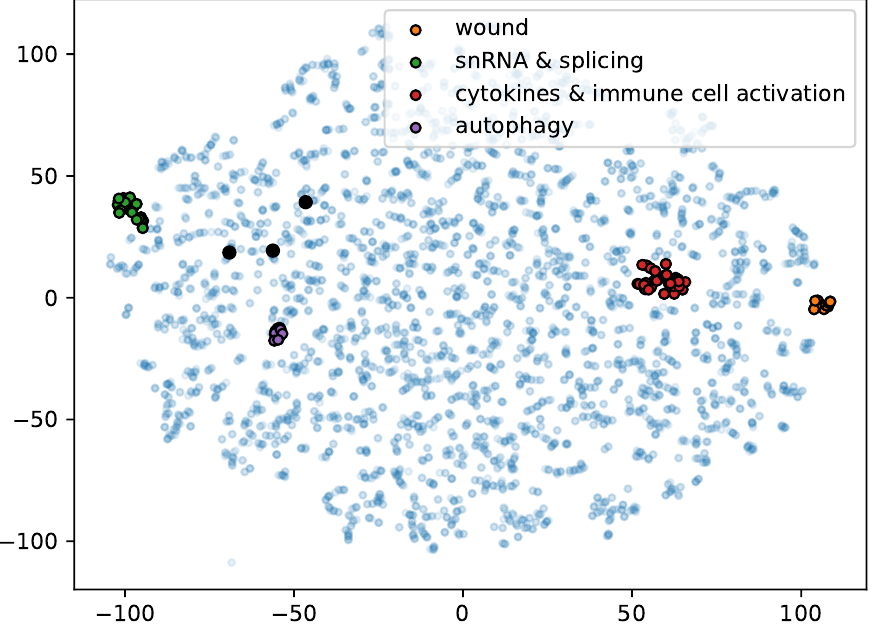
Figure 5. Two-dimensional tSNE embedding of GO terms from all three ontologies that annotate at least 0.1% of SwissProt entries. One minus the Pearson correlation of the occurence patterns of terms across SwissProt proteins was used as a distance measure for calculating the embeddings. Inspecting the terms in some of the clusters observed in this 2D space revealed that terms from the same cluster have similar meanings. Examples of clusters with terms that refer to wound healing, small nuclear RNAs and mRNA splicing complexes, cytokines and immune activation, and autophagy are shown in orange, green, red, and purple respectively. Terms “DNA binding”, “nucleus” and “DNA-templated regulation of transcription” are shown as larger black